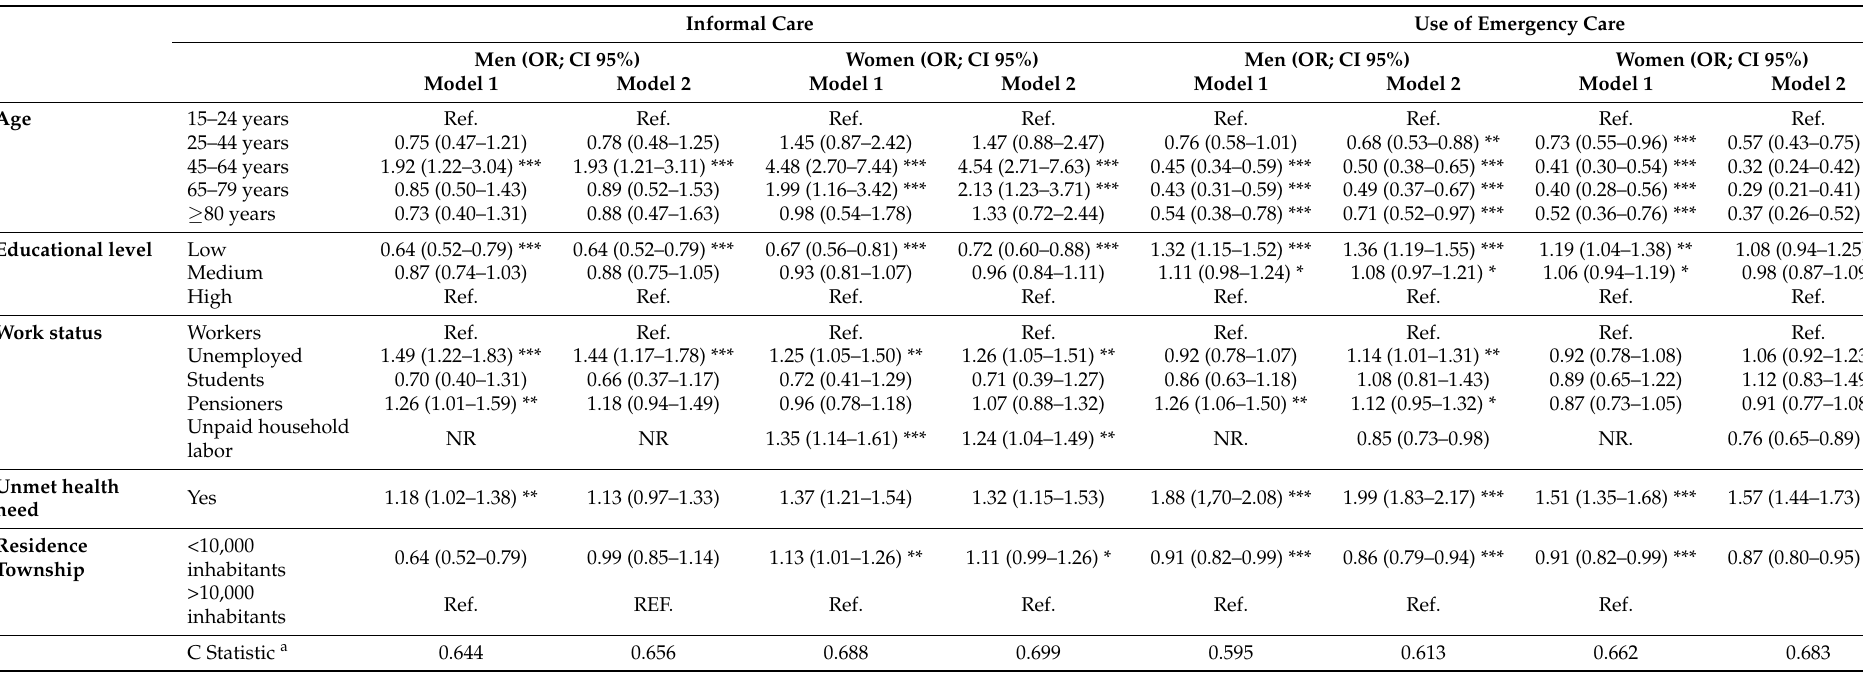
Table 5. Odds ratios and their 95% confidence intervals of informal care and use of emergency care by age, educational level, work status, unmet health care need, and residence township, stratified by sex. Spain